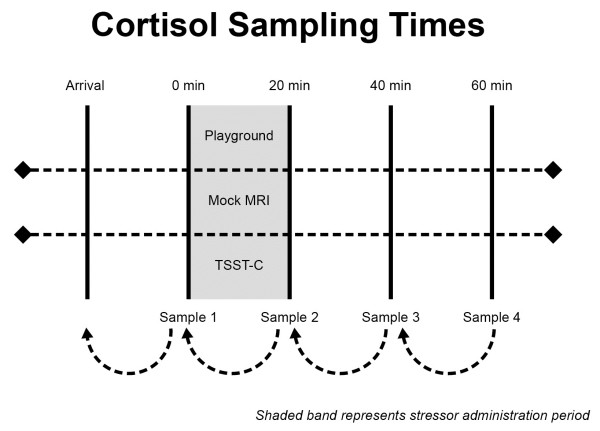
Timeline for saliva sampling across the different stressors.